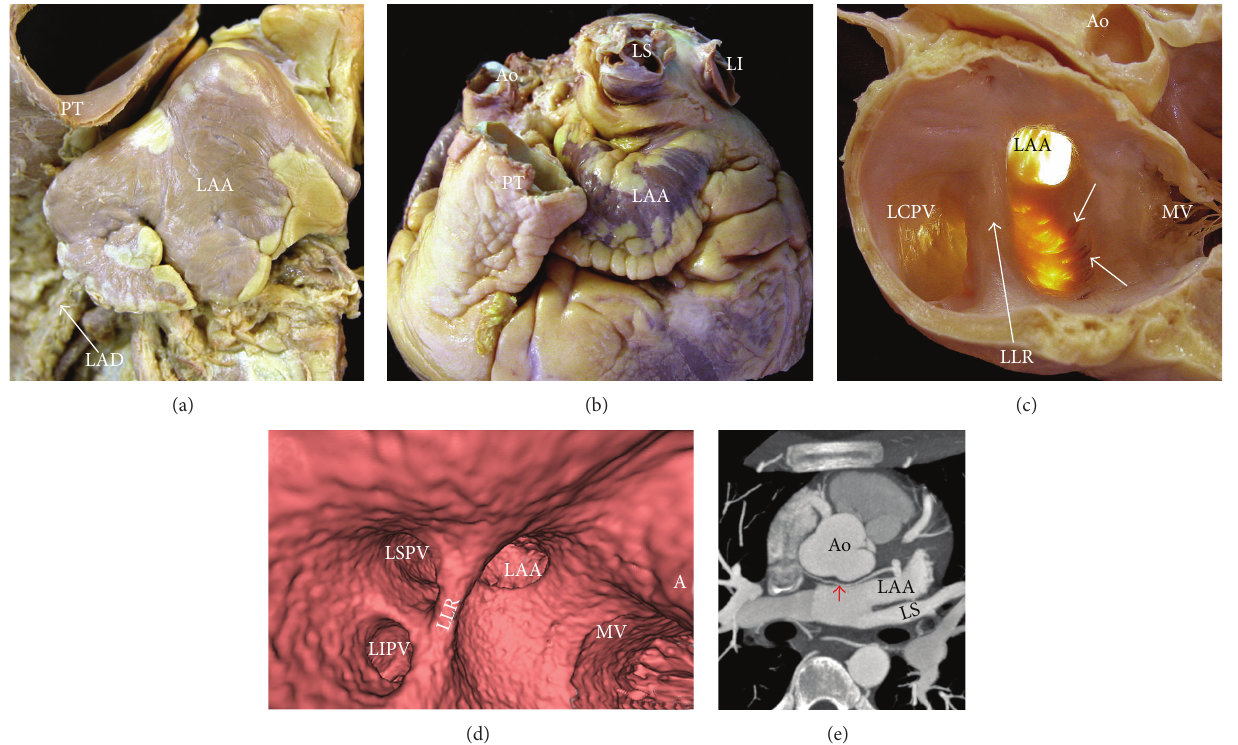
Figure 8: (a), (b) Images demonstrating significant interindividual variation in left atrial appendage (LAA) morphology (A: chicken wing; B: windsock). The tip of the LAA can be in a variety of positions, lying over the pulmonary trunk (PT) and the left anterior descending (LAD) coronary artery (a) or even directed medially towards the back of the aorta (b). (c) Endocardial visualization of the left posterolateral wall showing a prominent left lateral ridge (LLR) and extra pectinate muscle trabeculations (arrows) extending inferiorly from the appendage to the vestibule of the mitral valve. Transillumination in this specimen shows the atrial wall becoming exceptionally thin. (d) Endoscopic CT angiography view of the left posterolateral wall shows the relationship of the left superior pulmonary vein (LSPV) and the ostium of the LAA. In this example, both are located at the same level. The LLR is relatively thin. (e) Axial CT view at the left of the LAA shows a single lobe LAA and a thin LLR between the LAA and the left superior pulmonary vein (LS). The red arrow shows the left sinoatrial node artery arising from the left circumflex artery. Ao = aorta, LI = left inferior pulmonary vein, LS = left superior pulmonary vein, MV = mitral valve, and LCPV = left common pulmonary